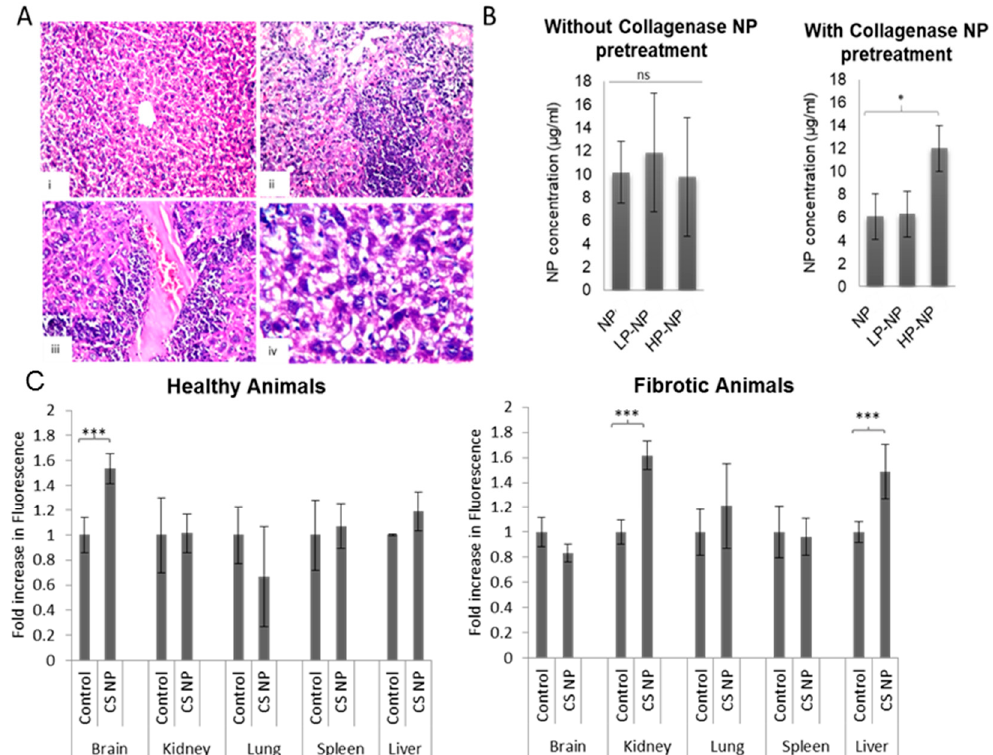
Figure 5. ( A ) Histopathological evaluation of liver sections obtained from healthy mice (i) and (ii-iv) mice receiving CCl 4 (magnification 40 × ) (i) Normal liver architecture and intact cells obtained from healthy mice receiving olive oil. (ii) Focal necrosis with inflammatory cells aggregation in hepatic parenchyma. (iii) Massive inflammatory cell infiltration surrounding the dilated, congested central vein. (iv) Diffuse degenerated hepatocytes in the parenchyma. ( B ) NP accumulation in fibrotic livers as a function of platelet-derived growth factor receptor-beta (PDGFR- β ) binding peptide density and collagenase-loaded NP pretreatment. ( C ) NP biodistribution in healthy and fibrotic animals. The results are expressed as the mean fold increase in fluorescence relative to untreated controls. Statistical analysis was performed by GraphPad InStat software using a one-way analysis of variance test (ANOVA), where (*) p < 0.05, (**) p < 0.01 and (***) p < 0.001.